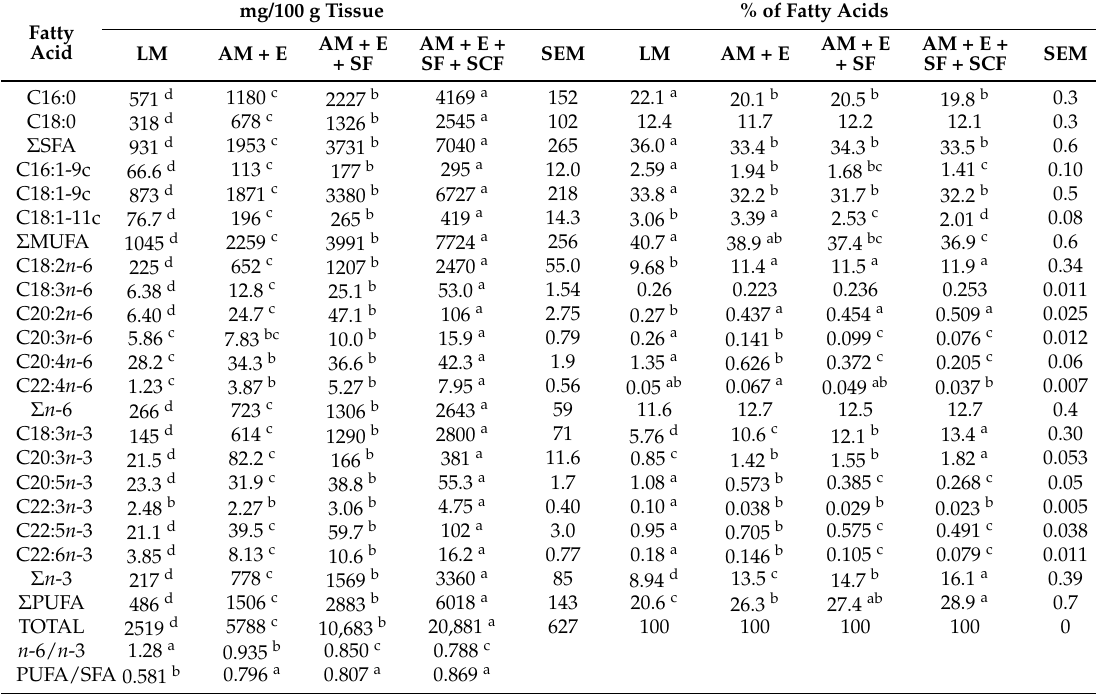
Table 2. The fatty acid composition of longissimus muscle and associated tissues in pork from pigs fed a diet supplemented with 10%